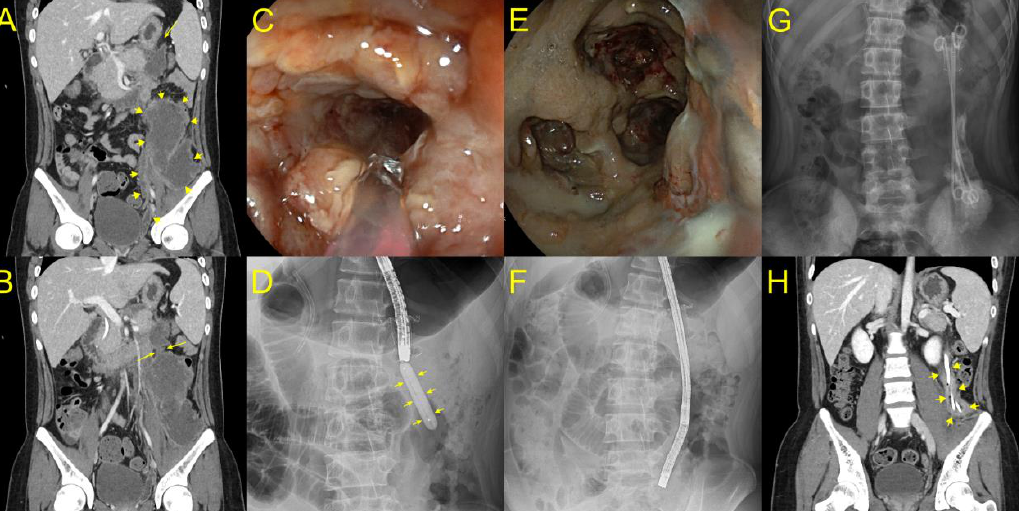
Figure 2. Placement of long plastic stents to the deep portion of walled off necrosis (WON) after direct endoscopic necrosectomy (DEN) for endoscopic treatment of laterally extended WON (yellow arrow) ( A ). ( B ) Computed tomography showing a huge WON extended to the left pelvic cavity communicating to a small portion of the necrotic cavity concatenated with the stomach through the narrow neck (yellow arrow) portion. ( C ) A gastroscope was inserted into the proximal portion of the WON through a lumen-apposing metal stent (LAMS), and we found a luminal stricture of the neck portion of WON. ( D ) Balloon dilatation (yellow arrow) was performed for deep insertion of an endoscope to the laterally extended WON. ( E , F ) The cavity was lavaged with normal saline, and necrotic debris was progressively removed with snare and grasping forceps. ( G ) After DEN, three plastic stents with double pigtail configuration were fixed in place through the LAMS to the deep portion of WON until the next session of DEN. ( H ) After 16 DEN sessions, where the long plastic stents remained in the deep portion of WON, the patient recovered with complete WON resolution (yellow arrow).